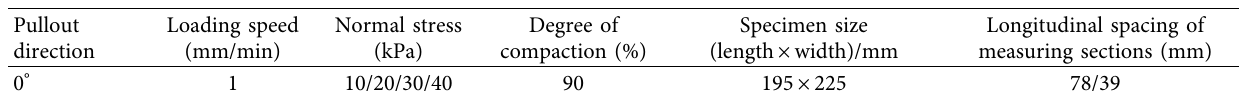
Table 3: Testing